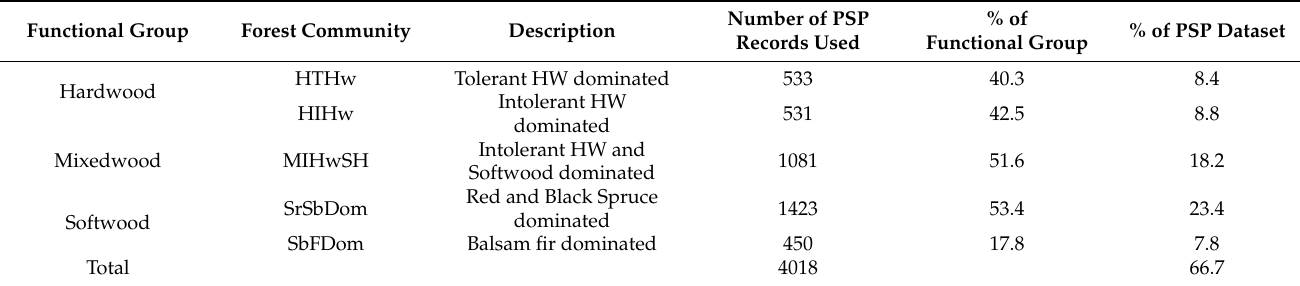
Table 1. Breakdown of PSPs by the forest communities used in the analysis (all available plots with both biomass and necromass measurements, after age- and forest community-related omission). Functional